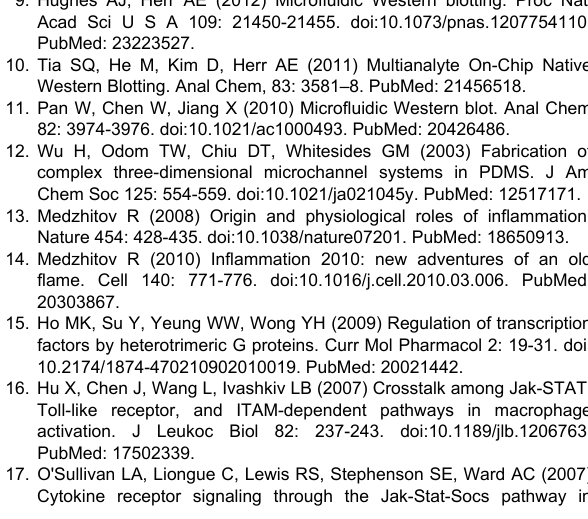
Figure S2. Example of microfluidic protein immunoblot generated using a 5-channel per lane microfluidic